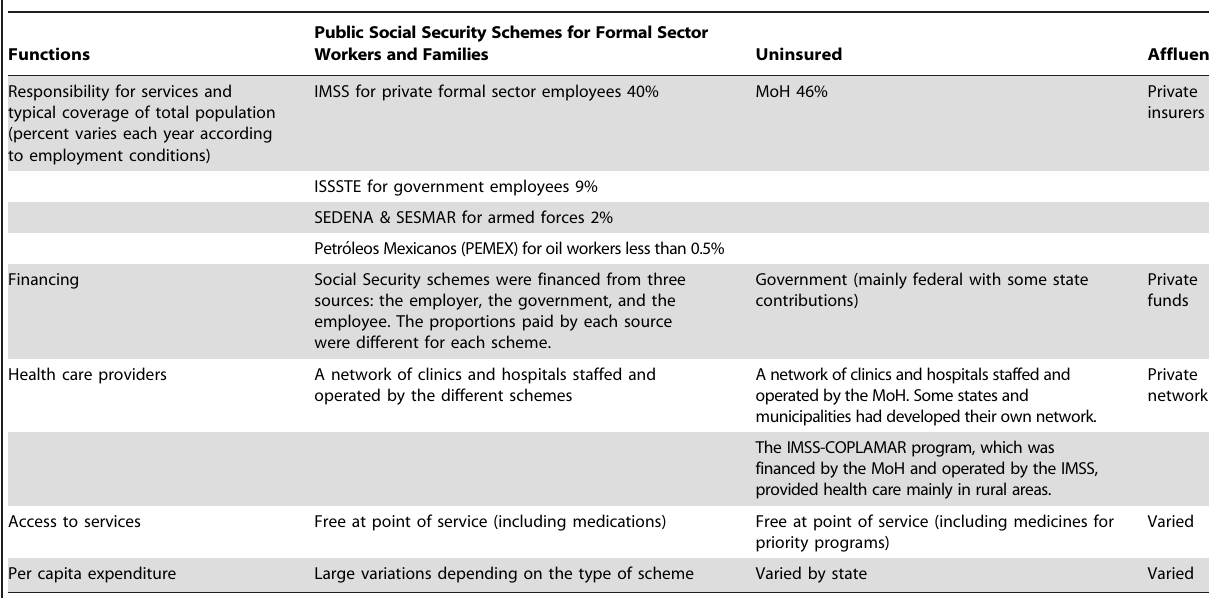
Table 2. The Mexican health care system (prior to